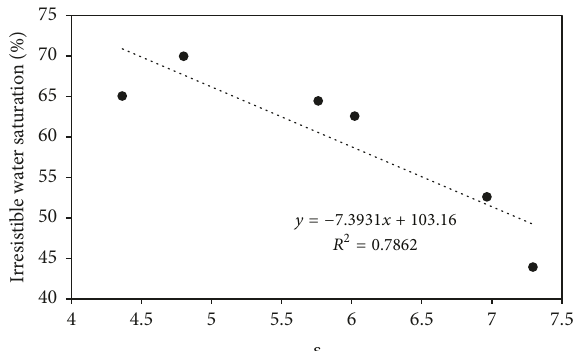
Figure 15: The correlation of the combination parameter of pore- throat structure ( 𝜀 ) and irresistible water saturation. The detail of 𝜀 refers to the footnote of Table